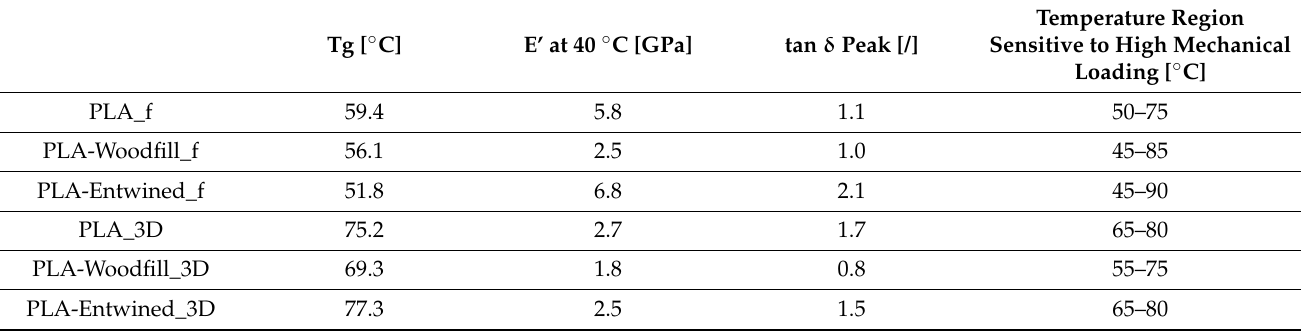
Table 4. Glass transition temperature (Tg), bending storage modulus (E’) at 40 ◦ C, damping factor (tan δ ) and temperature region sensitive to high mechanical loading of